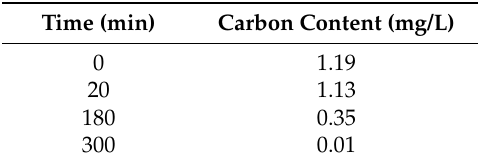
Table 2. Total organic carbon content of aspirin solution.